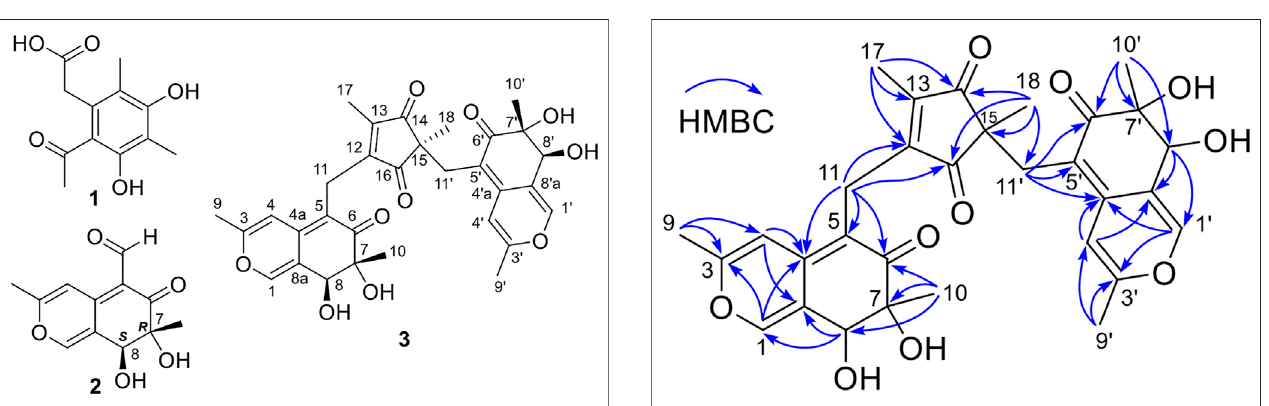
Compound 3 ( Figure 1 ) was also obtained as yellow powder.